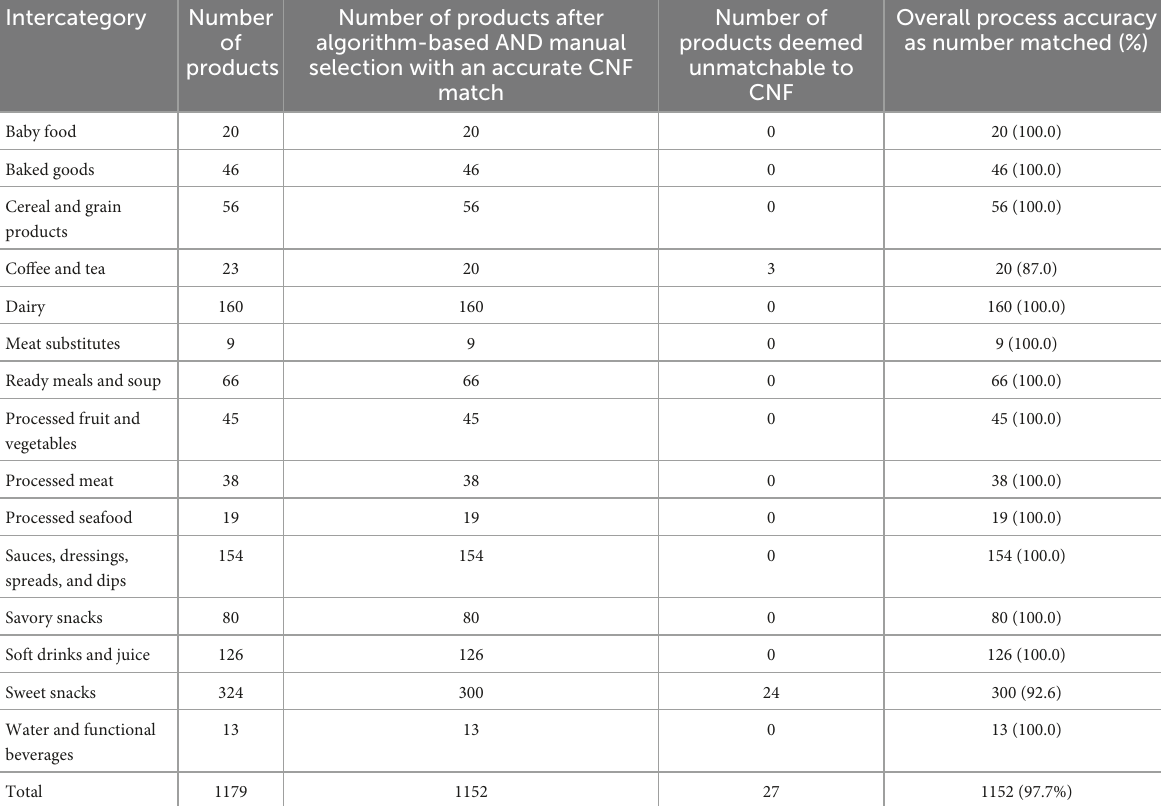
TABLE 4 Process accuracy, overall and by intercategory. Intercategory Number Number of products after of algorithm-based AND manual products selection with an accurate CNF